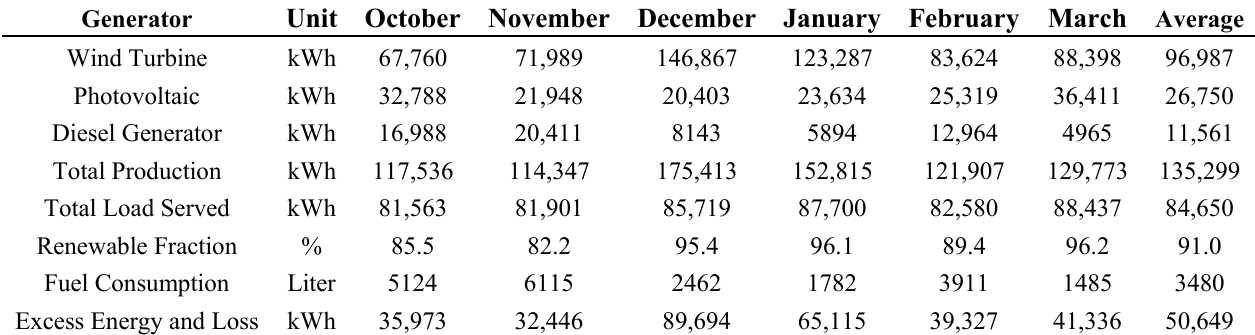
Table 8. Expected energy production and load of the test island by